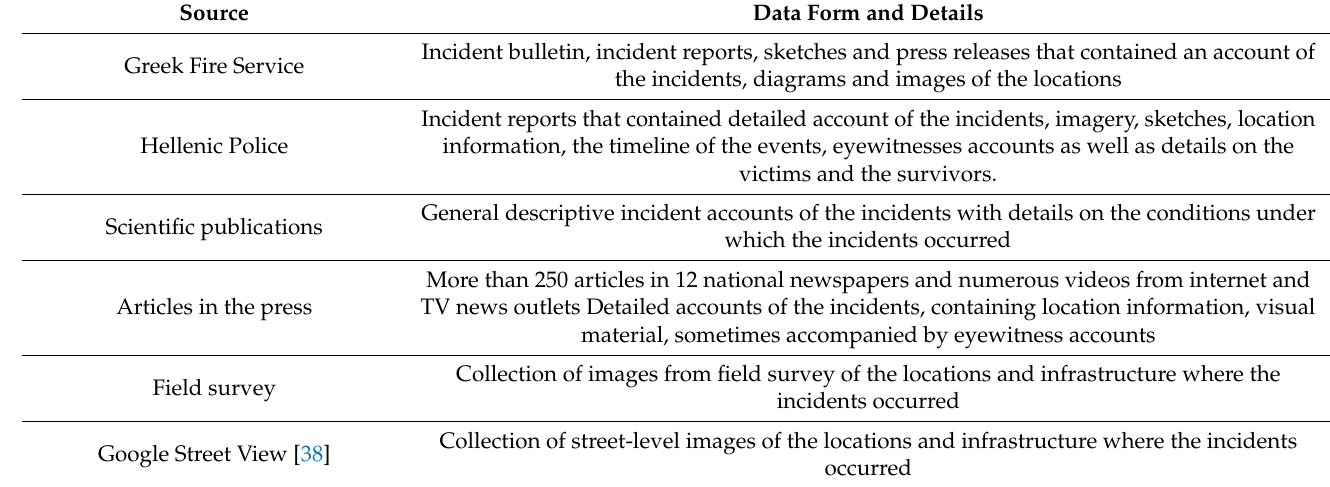
Table 1. Sources of flood fatality information (1960–2020), with details of the type of information provided by each